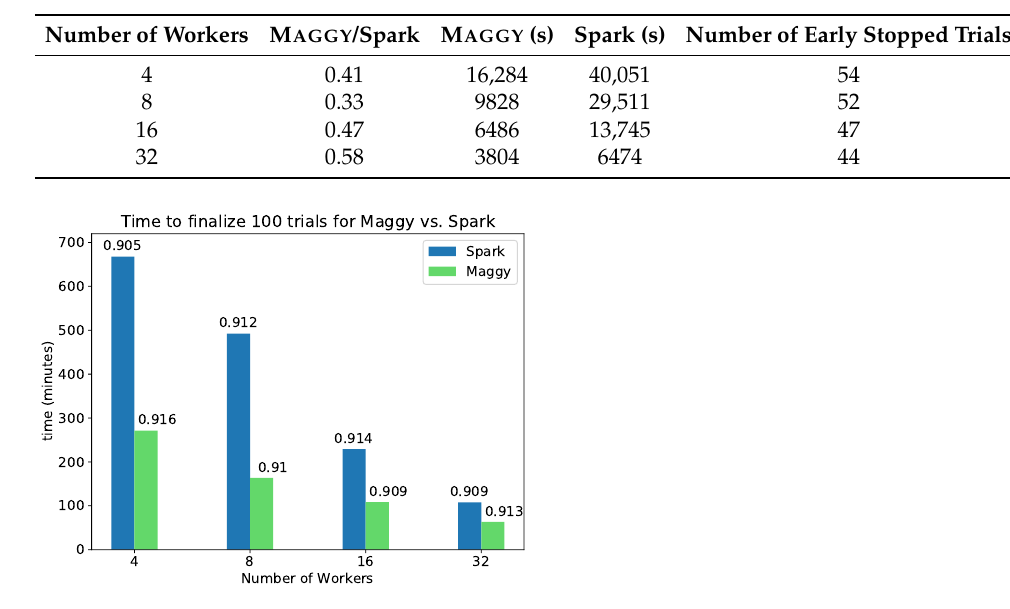
Figure 13. When compared to Spark (the Experiment API), the asynchronous execution of trials and the median stopping rule in M AGGY allow 100 hyperparameter trials to be executed in a lower wall-clock time (lower is better) without any loss in accuracy (denoted on top of the bars). We can also see that both M AGGY and Spark exhibit linear scalabilities (linear reductions in the experiment’s wall-clock time) when more workers are added